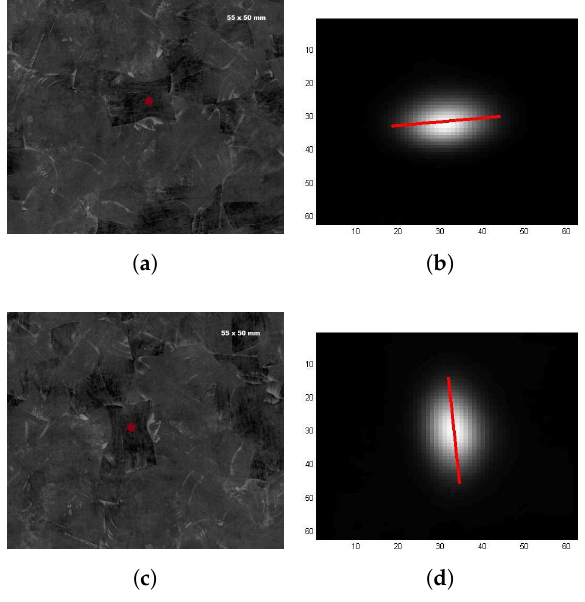
Figure 8. PTE inspection of single strand. Second strand: ( a , b ) plate on its original position; and ( c , d ) plate rotated 90 ◦